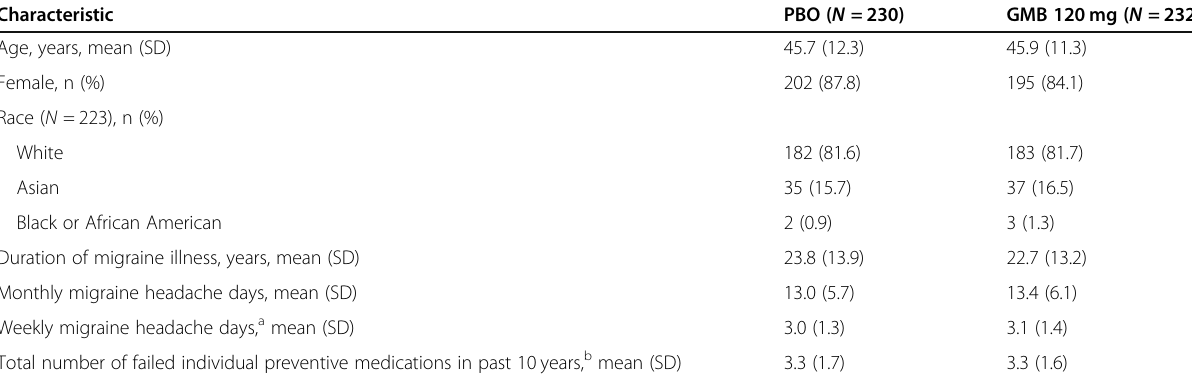
Table 1 Patient demographics and baseline disease characteristics